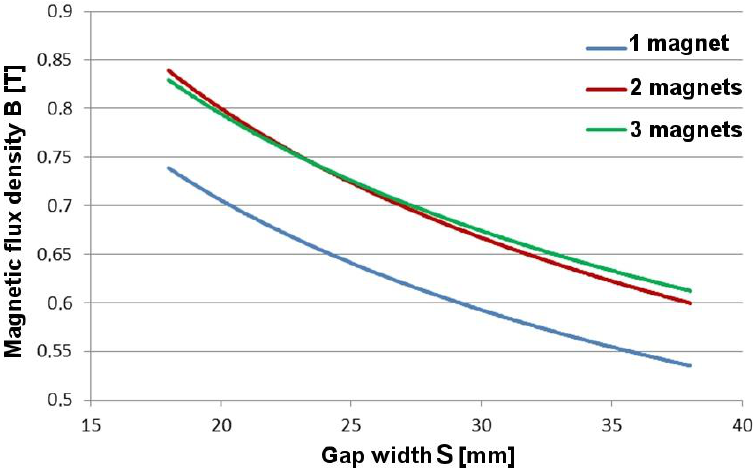
Figure 14. Impact on the magnetic flux on the surface of separators depending on the machining gap width and number of magnets, obtained from measurements.